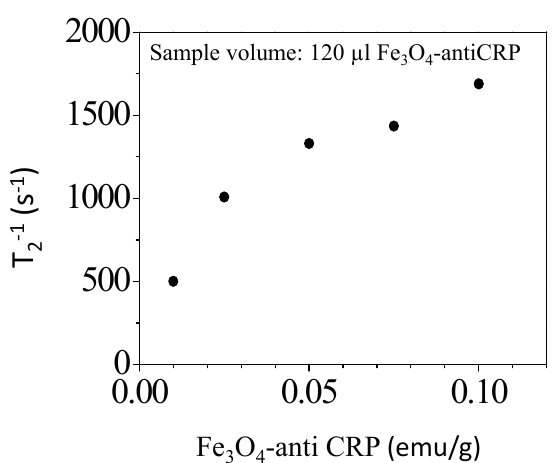
Figure 3. Relaxation rate T 2 − 1 of protons as a function of Fe 3 O 4 -antiCRP saturated magnetization in unit of